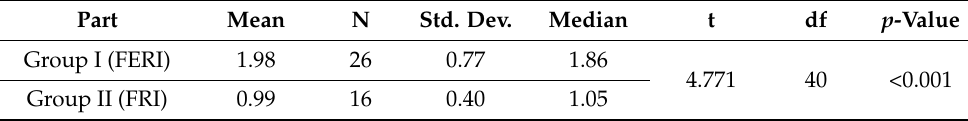
Table 7. Comprehension efficiency of the second test (independent sample